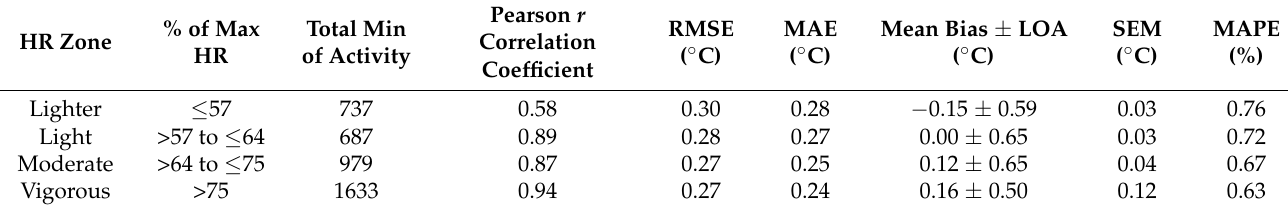
Table 3. Kenzen T C algorithm accuracy binned by age-predicted maximum HR zones.